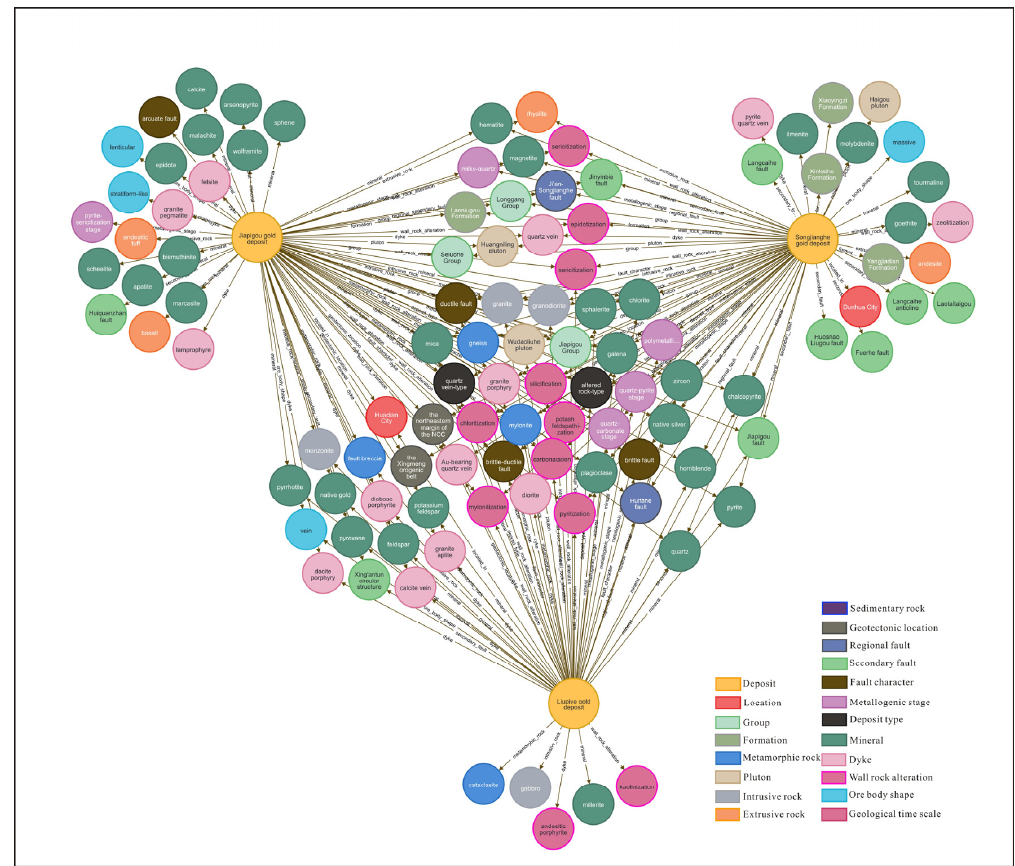
Figure 18. A comparison of the geological entities of the Songjianghe, Liupiye, and Jiapigou gold deposits based on the KG. Table 11. A comparison of the main geological characteristics of the Jiapigou, Liupiye, and Songjianghe gold